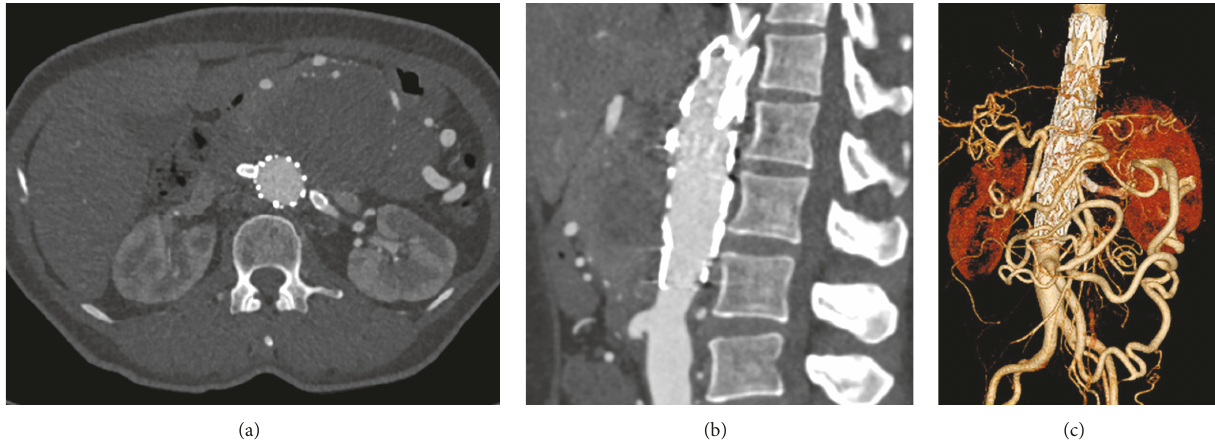
Figure 4: CTA: axial view, no endoleak (a). Sagittal view: stent placed superior to inferior mesenteric artery orifice (b). Reconstruction view: adequate flow from the inferior mesenteric artery to supply the celiac artery and superior mesenteric artery.